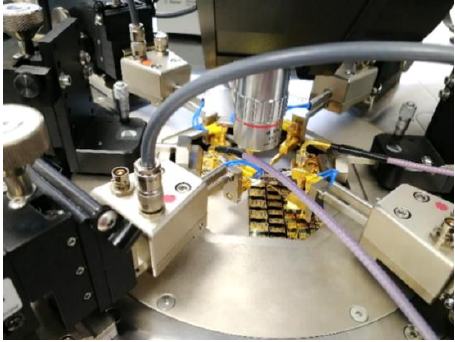
Figure 6. Photograph of the measurement setup featuring both RF and DC microprobes.